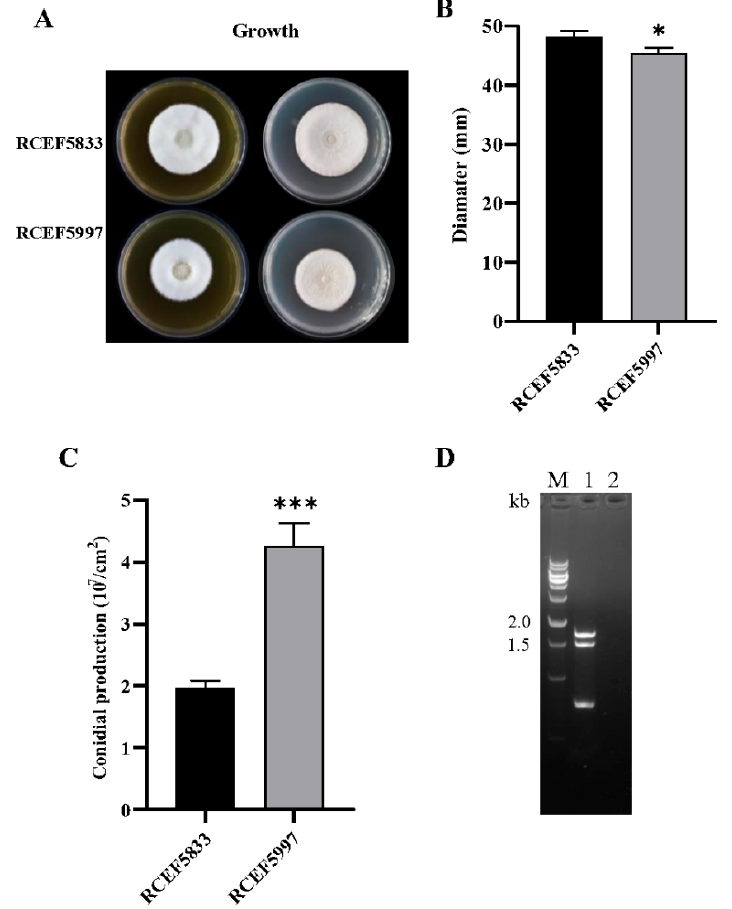
Figure 1. Fungal development and virus infection of Cordyceps chanhua strains. ( A ) Colony morphology of C. chanhua strains RCEF5997 and RCEF5833 on PDA medium. ( B ) Diameters of strains grown on SDAY for 10 days. ( C ) Sporulation capacity of strains RCEF5997 and RCEF5833 growing on PDA medium after 10 days. ( D ) Electrophoresis of purified dsRNAs extracted from C. chanhua strains RCEF5997 and RCEF5833 in a 1.5% agarose gel. M, DNA marker; lane 1, dsRNA segments of RCEF5997; lane 2, RCEF5833 did not possess any dsRNA. * p < 0.05, *** p < 0.001.